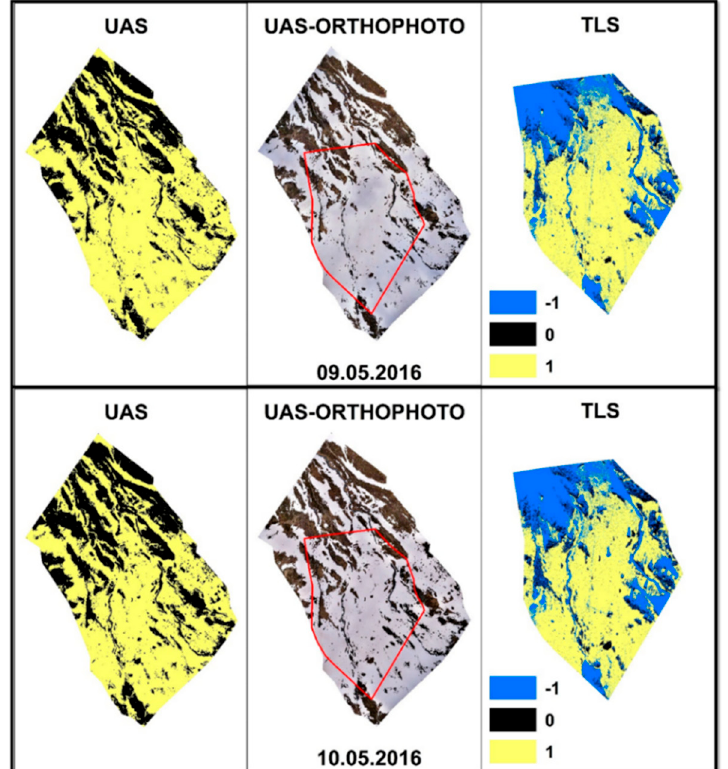
Figure 6. Cont Figure 6. Cont.